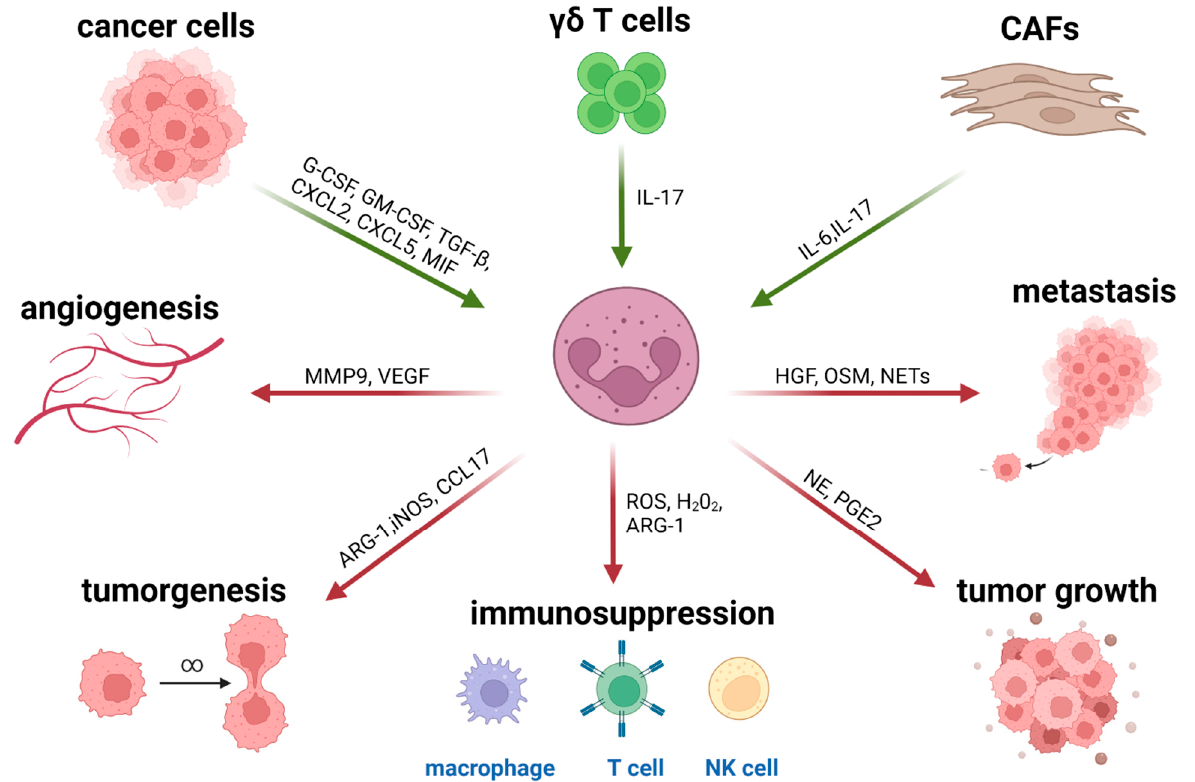
Figure 1. Neutrophils are recruited to the tumor site in response to TME-derived stimuli such as chemokines and cytokines (green arrows). Polarized TANs exert immunosuppressive and protumor functions with the aid of neutrophil-derived factors such as granule enzymes and reactive oxygen species (red arrows).